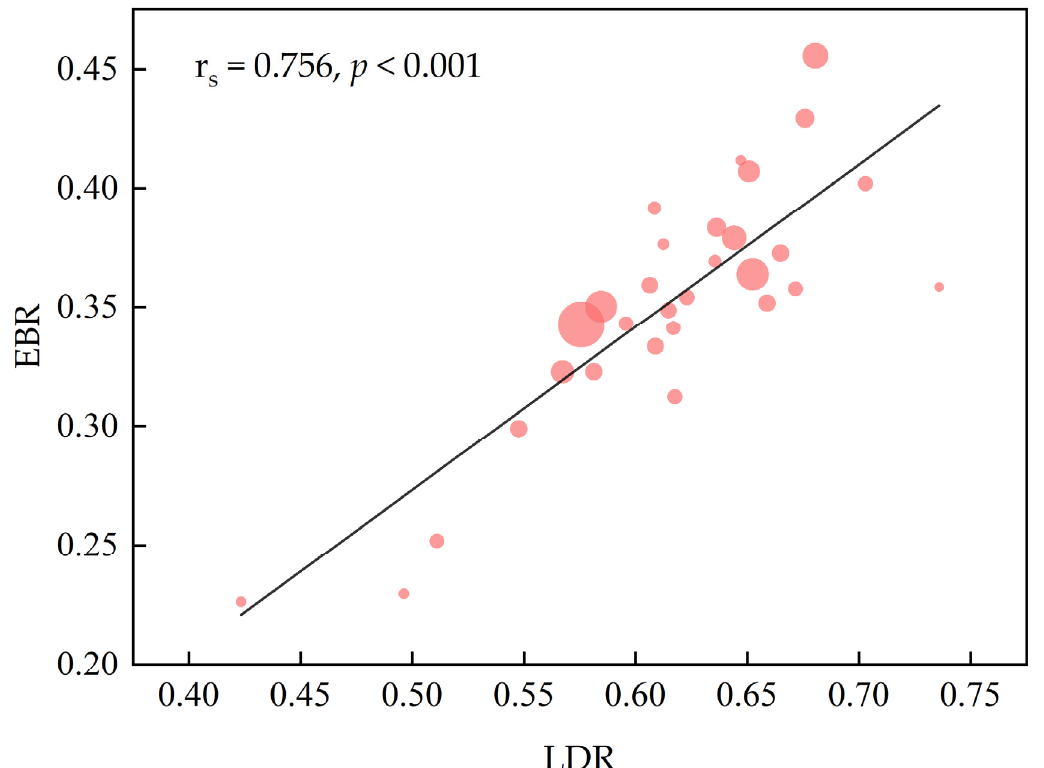
Figure 4. The association between EBR and LDR. Each circle represents a single endoscopist’s performance and the diameter of the circle represents the number of esophagogastroduodenoscopies performed by the endoscopist. LDR, lesion detection rate; EBR, endoscopy biopsy rate; rs, Spearman correlation.